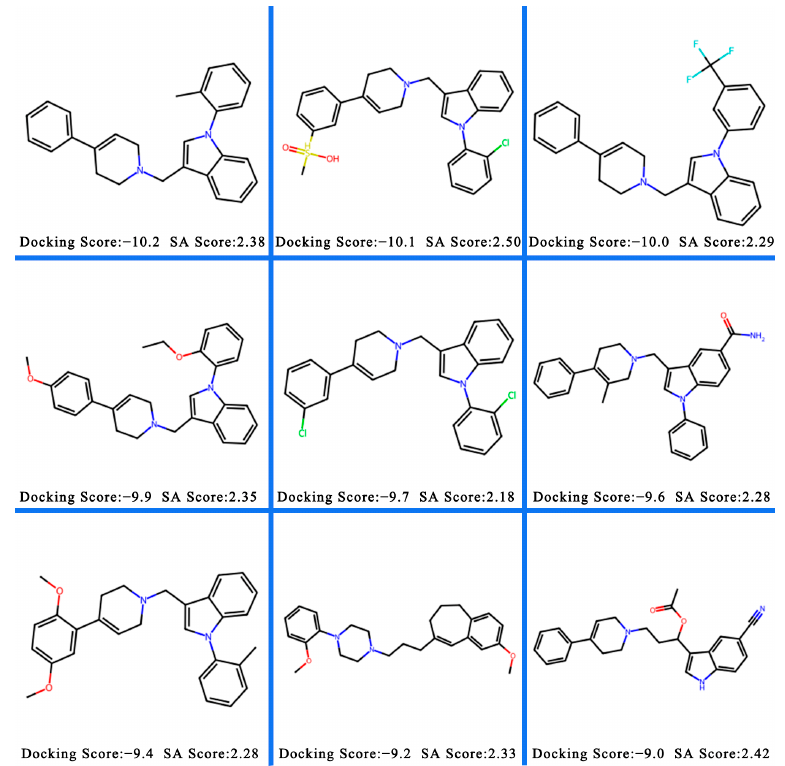
Int. J. Mol. Sci. 2023 , 24 , x FOR PEER REVIEW Figure A2. Example of generated molecules for target S1PR1. Figure A2. Example of generated molecules for target S1PR1.